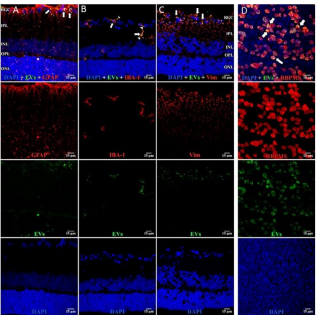
Figure 4. EVs in microglia and in astrocytes and additional confirmation of EVs in RGCs. Retinal 10 m-thick cryosections were prepared 7 days after injection of fluorescent green labeled EVs, and examined using confocal microscopy. Immunostaining for, left to right, ( A ) astrocytes and Muller cell footplates (anti-GFAP), ( B ) microglia (anti-IBA-1), ( C ) cytoplasmic processes of astrocytes and Muller cells (anti-vimentin, “Vim”). DAPI stained nuclei blue. Arrows indicate overlap (yellow color) of green labeled EVs and red (GFAP, IBA-1, or Vim). Arrowhead in ( B ) shows vesicular-appearing EV staining inside microglial cells. Cell layer names provided in ( A ) and ( C ) also apply to ( B ); 40 × . RGC = retinal ganglion cell layer; IPL = inner plexiform layer; INL = inner nuclear layer; OPL = outer plexiform layer; ONL = outer nuclear layer. Staining for GFAP and EVs (A) confirms that most EVs in Muller cells are in the footplates. Most staining for EVs in microglia (yellow) in (B), and astrocytes/Muller cells (C), was in the retinal ganglion cell layer and inner plexiform layer. ( D ) Flat mounts with anti-RBPMS (red), EVs (green), and DAPI blue. Nearly all red staining RGCs also contain green EVs (yellow overlap, arrows in top panel in D), providing further support that EVs were taken up by RGCs. Scale bars (15 µ m) are on the bottom right of each panel 63x.